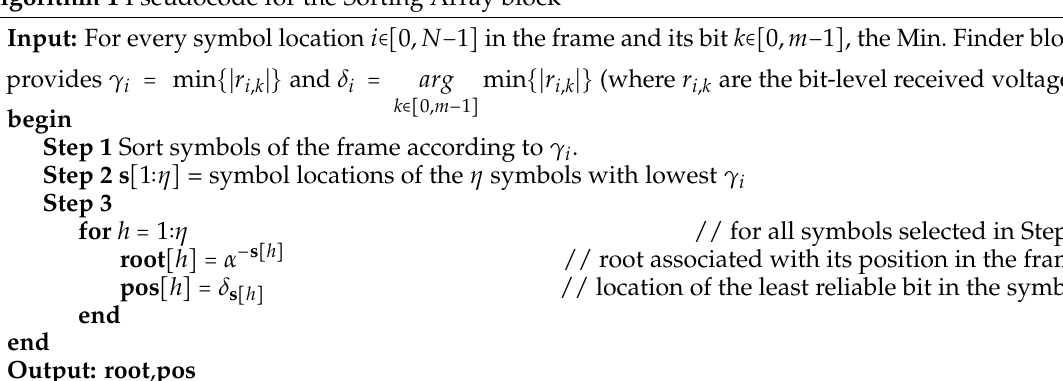
Figure 5. Schematics of the Sorting Array block. Note that the first column is different than the rest, since “Din” and “shift in” inputs do not exist. Algorithm 1 Pseudocode for the Sorting Array